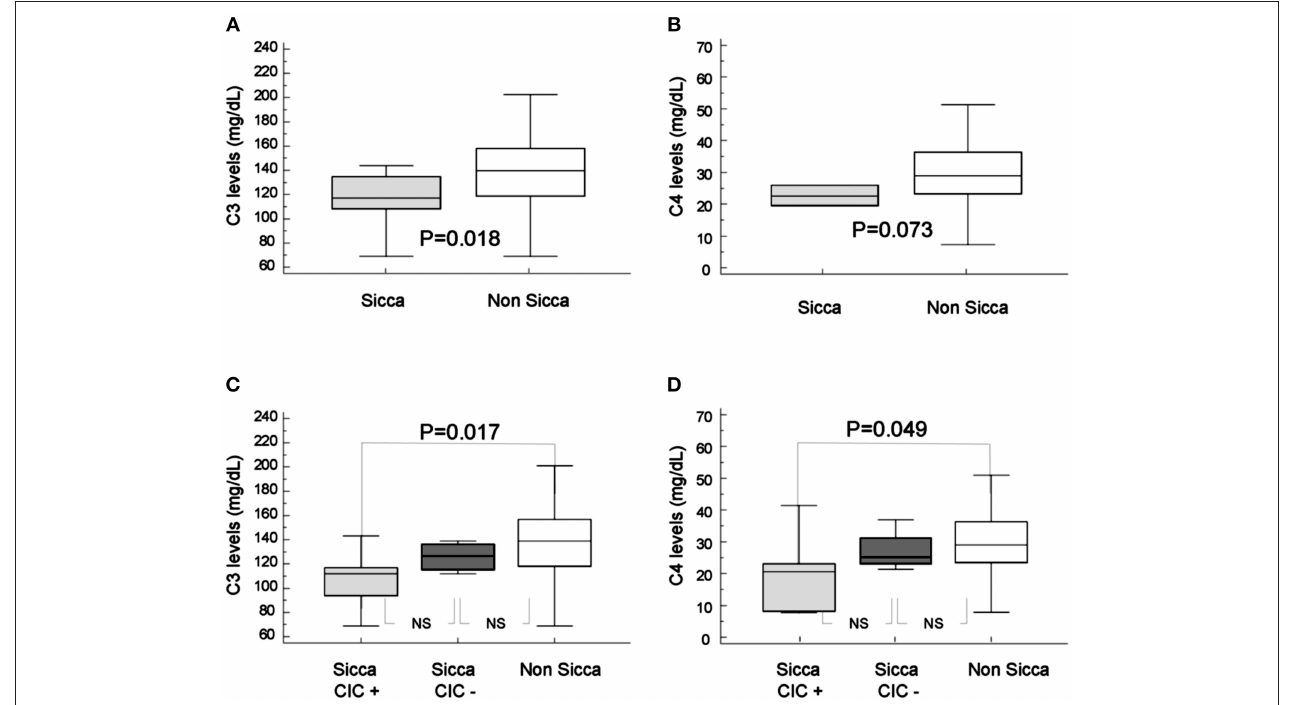
FIGURE 2 | Mean levels of C3 (A) and C4 (B) complement in patients with ophthalmic sicca (gray box) and without sicca (white box). Mean levels of C3 (C) and C4 (D) complement in patients with sicca and circulating immune-complexes (gray box), with sicca and without circulating immune-complexes (dark box) and without sicca (white box). Mean levels of C3 and C4 in 10 patients with sicca (115.1 ± 6.9 and 23.1 ± 3.4 mg/dL, respectively) and mean levels of C3 and C4 in 47 patients without sicca (140.5 ± 4.5 and 30.4 ± 1.7 mg/dL, respectively). Levels of C3 were significantly lower in patients with sicca ( p = 0.013), levels of C4 were lower but the difference was not statistically significant ( p =